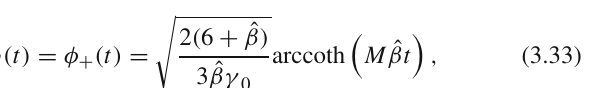
Fig. 1 Behavior of h (φ) (left) and V (φ) (right) associated with φ + ( t ) for ˆ β = 0 . 1 and γ Here, h 0 is an integration constant. This plot shows that h (φ) is smaller than one when φ is close to zero. In addition, it also shows that V (φ) is not negative definite for all values of φ